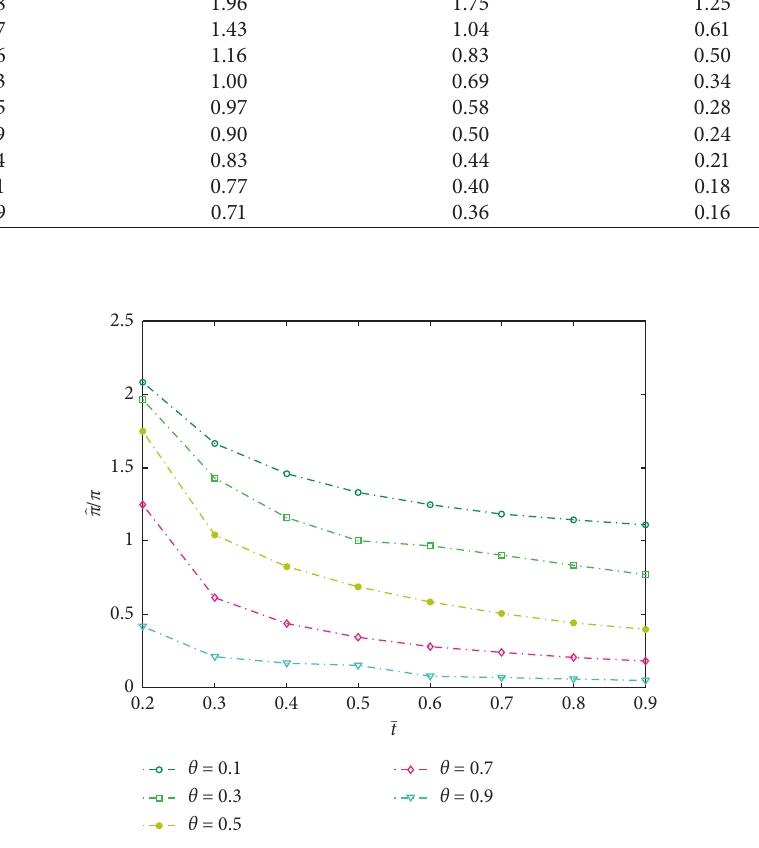
Figure 7: The effect of θ and t on the profit ratio 􏽢 π / π